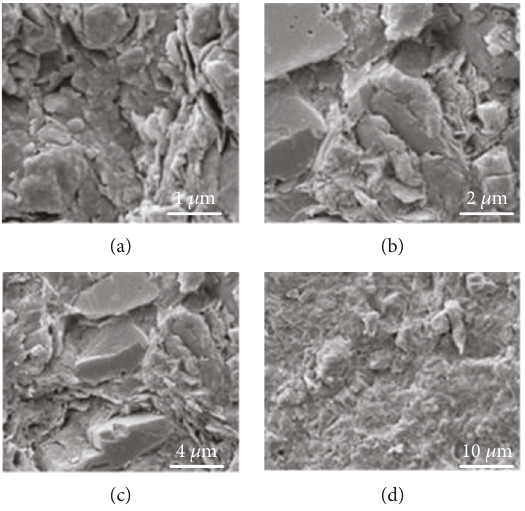
Figure 3: The SEM images of LMX